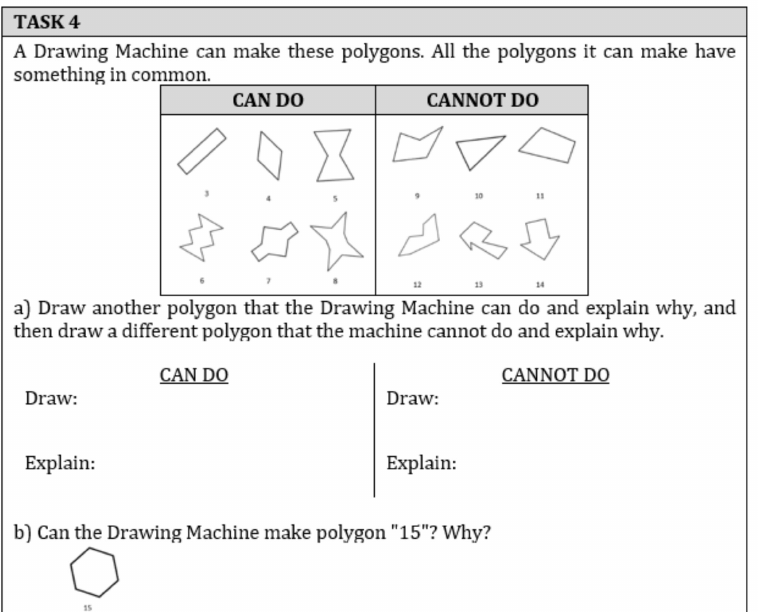
Figure 4. Example of a task in the middle interview: identify the attribute that defines a class (having two axes of symmetry), represent examples and non-examples of the class and identify examples of figures of the identified